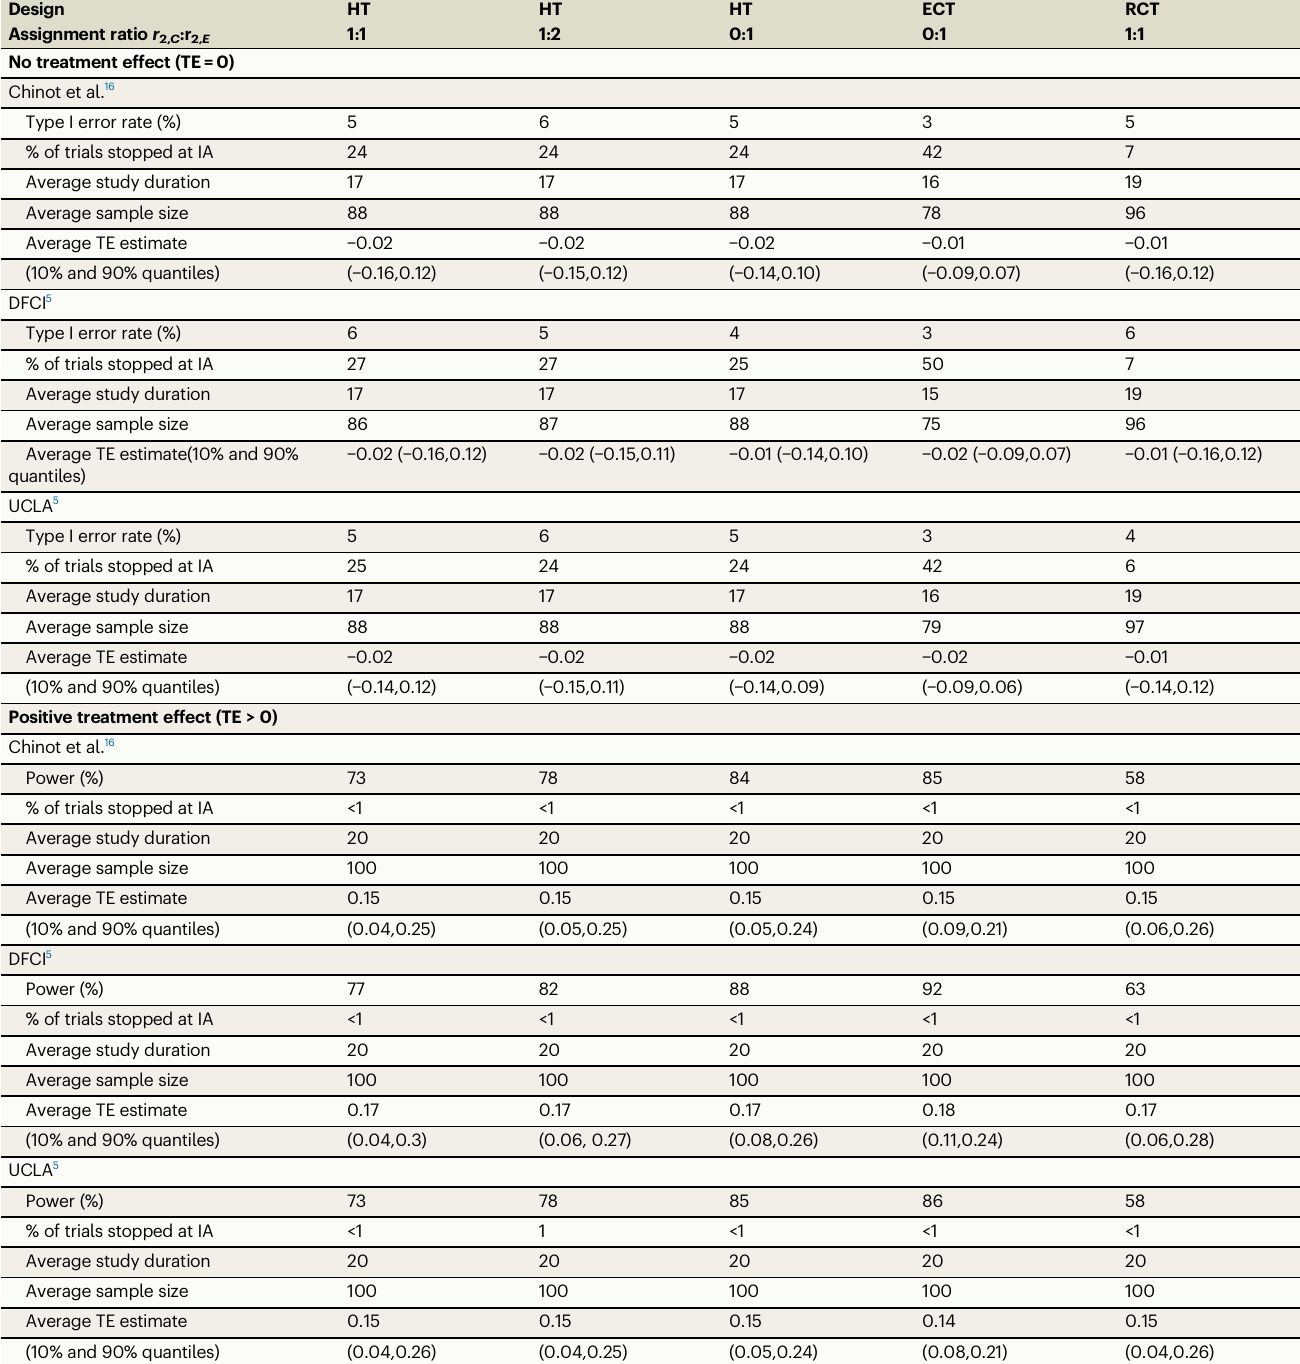
Table 3 | Resampling-based evaluation of the operating characteristics of the HT, ECT, and RCT designs in GBM